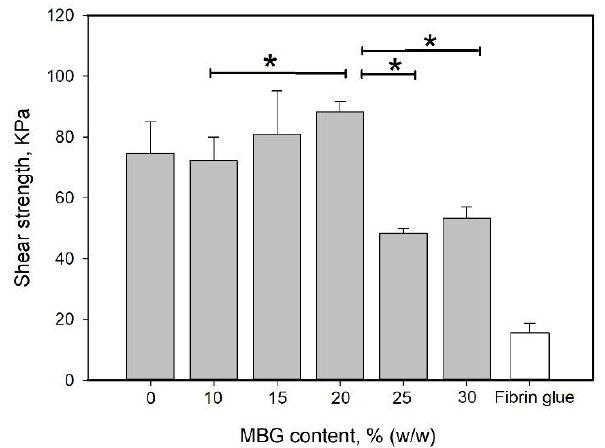
Figure 8. E ff ect of MBG content on shear strength. MBG was added to and mixed well with the 90G10C solution to a content ranging from 10 to 30% ( w / w ). Then, 100 µ L of the mixed solution was applied to the porcine skin strips. The 1 cm 2 overlap area was irradiated by an LED curing light for 120 s. Data are presented as the mean ± SD (n = 9) and were analyzed using the nonparametric Kruskal–Wallis H-test. Di ff erences of p < 0.05 were considered statistically significant. (*) denotes a significant di ff erence ( p < 0.05).